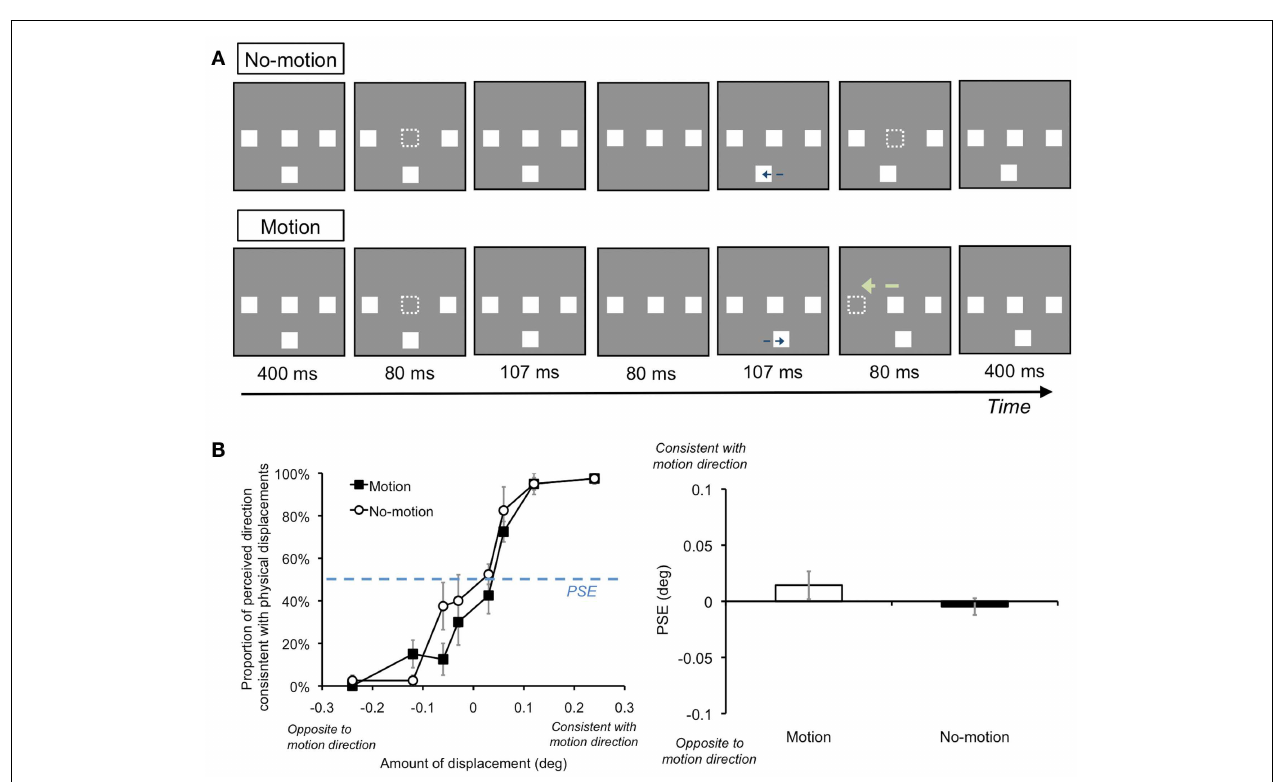
proportion at which the perceived direction of the target was consistent with the possible shadow motion direction in each motion condition. Regarding the estimated point of subjective equality (PSE), a two-tailed paired t test found that differences in PSEs between the Motion and No-motion conditions was not significant [ t (3) = 1.13, n.s .].These results indicate that perceptual displacements could well occur with stimulus motion of AM stimuli in our current experimental situations. Error bars denote standard errors of the mean ( N =